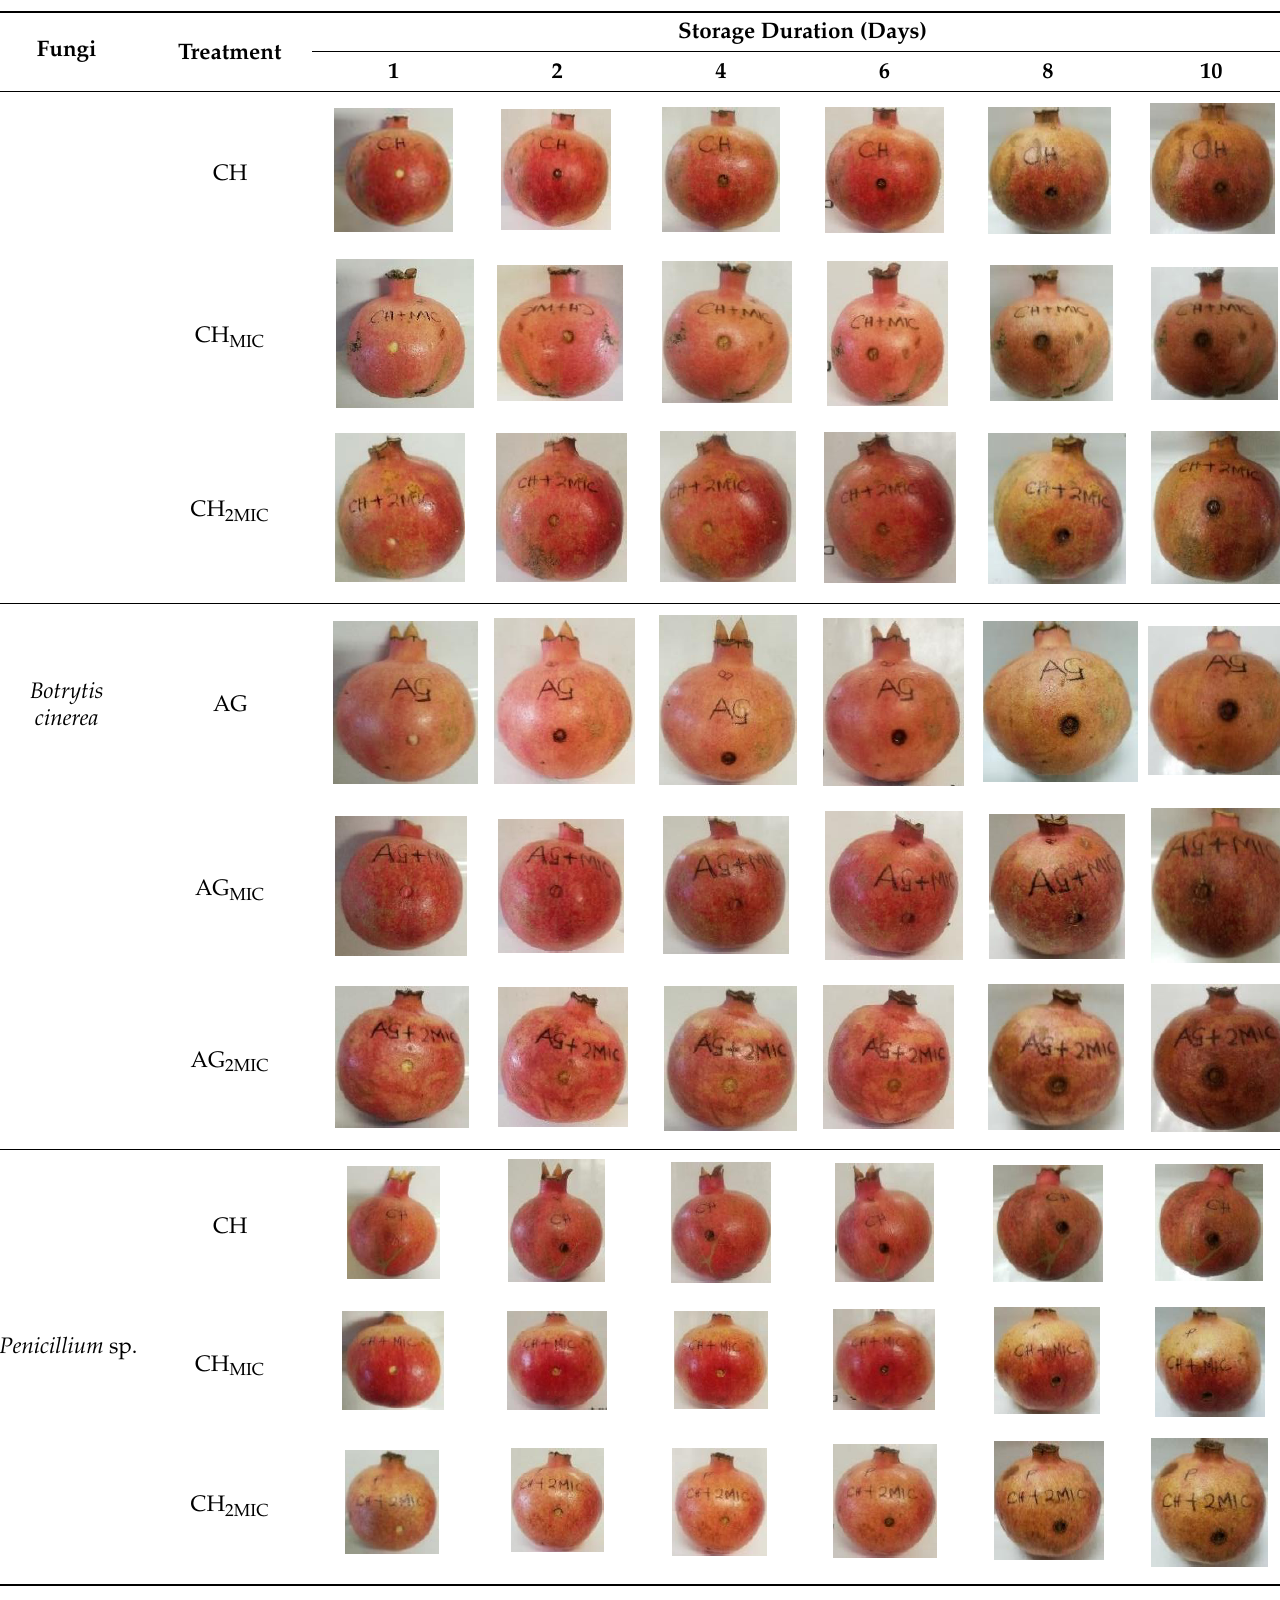
AG 2MIC —sodium alginate formulated with lemongrass oil at double the minimum inhibitory con- centration (30 or 60 µL/mL). Vertical bars represent the standard error (SE) of mean values of three Table 2. Decay severity of coated ‘Wonderful’ pomegranate inoculated with Botrytis cinerea and Penicillium spp. during 10 days of storage (22 °C for B. cinerea and 25 °C for Penicillium spp.). Fungi